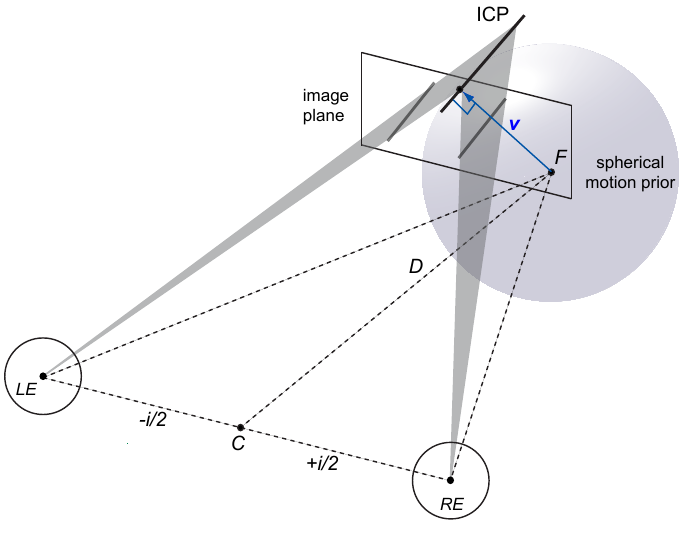
Figure 2. Illustration of the Bayesian vector normal (BVN) model. Inverse projection of the line stimulus into the left and right eye are illustrated by 2D velocity constraints on an image plane (grey lines), resulting in two 3D velocity constraint planes (shaded triangles), and their intersection (ICP). The ICP describes an oriented line moving from the start point F to the left and away from the observer. The translucent sphere centred on fixation point F denotes a weak prior for slow motion in 3D. If the constraint planes have very little noise and are combined with the spherical prior in a Bayesian inference then the resulting 3D velocity estimate ˆ v approximates the vector normal (blue